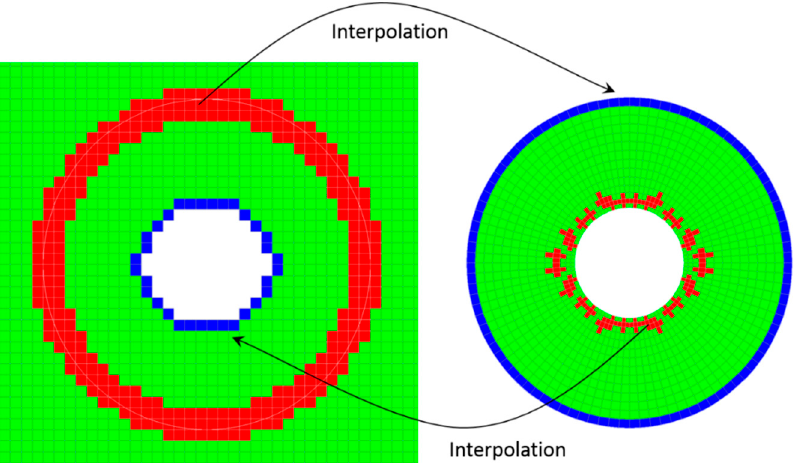
Figure 2. Mesh connectivity technique: ( left ) background grid and ( right ) component grid. Green corresponds to “solve cells”, red to “donor cells”, and blue to “receptor cells”.